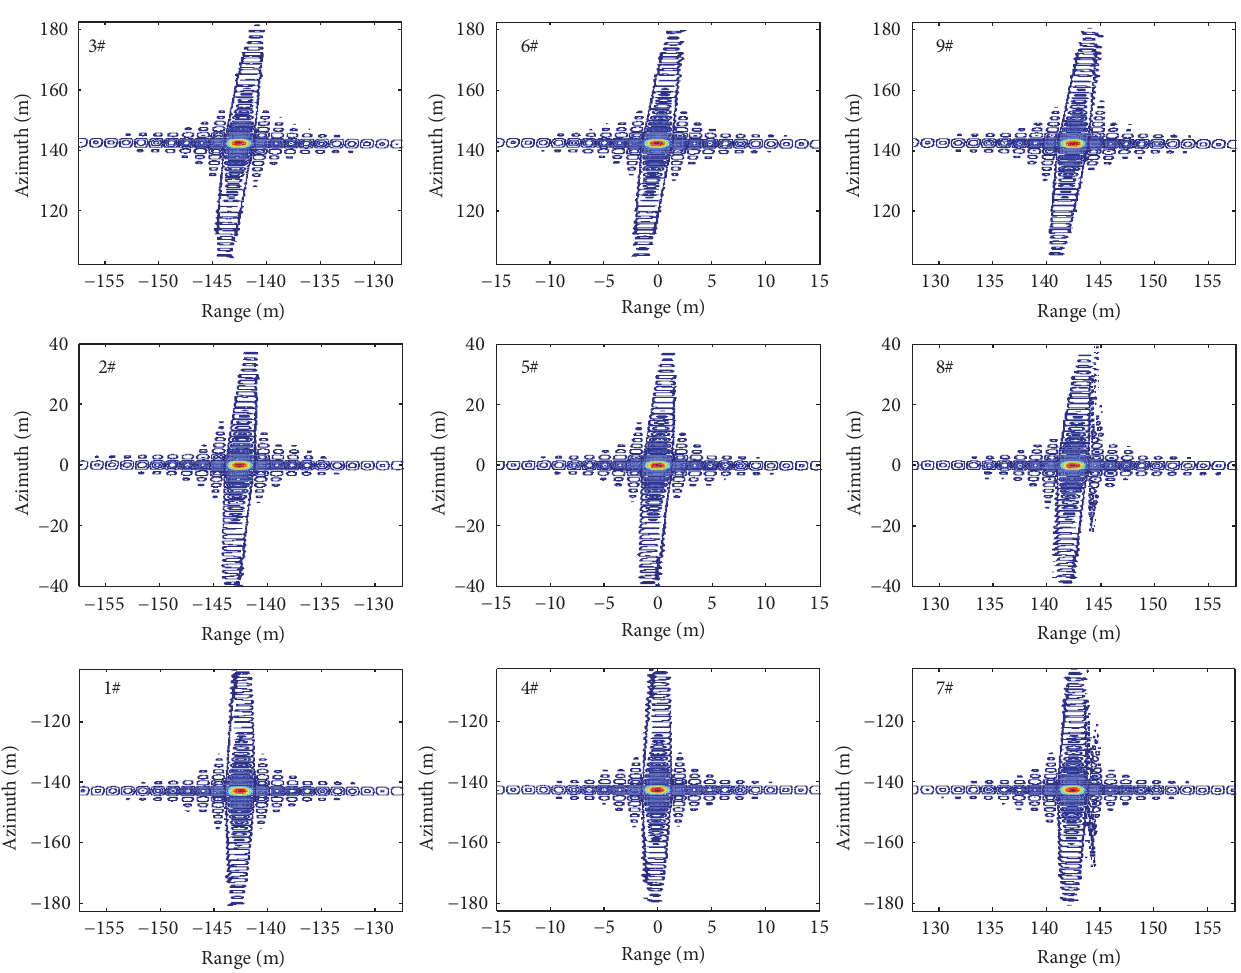
Figure 10: Imaging result of frequency stepped SAR with FDEM and DBP-FFBPA, dynamic range: 40 dB.